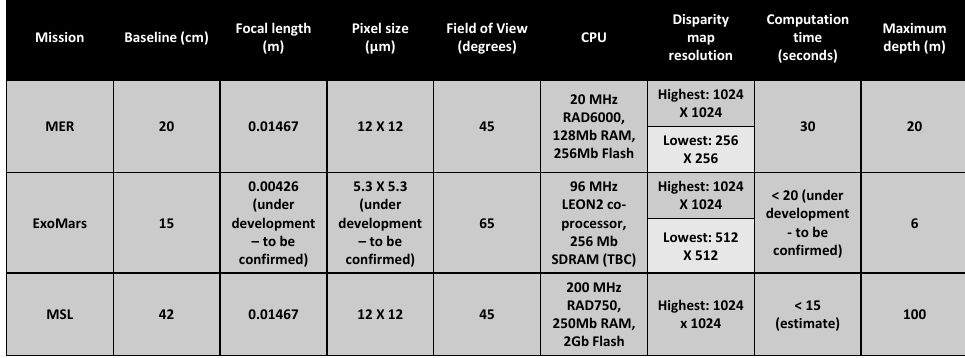
Figure 2. Comparison of the stereo depth perception systems on board MSL, MER, ExoMars rovers.